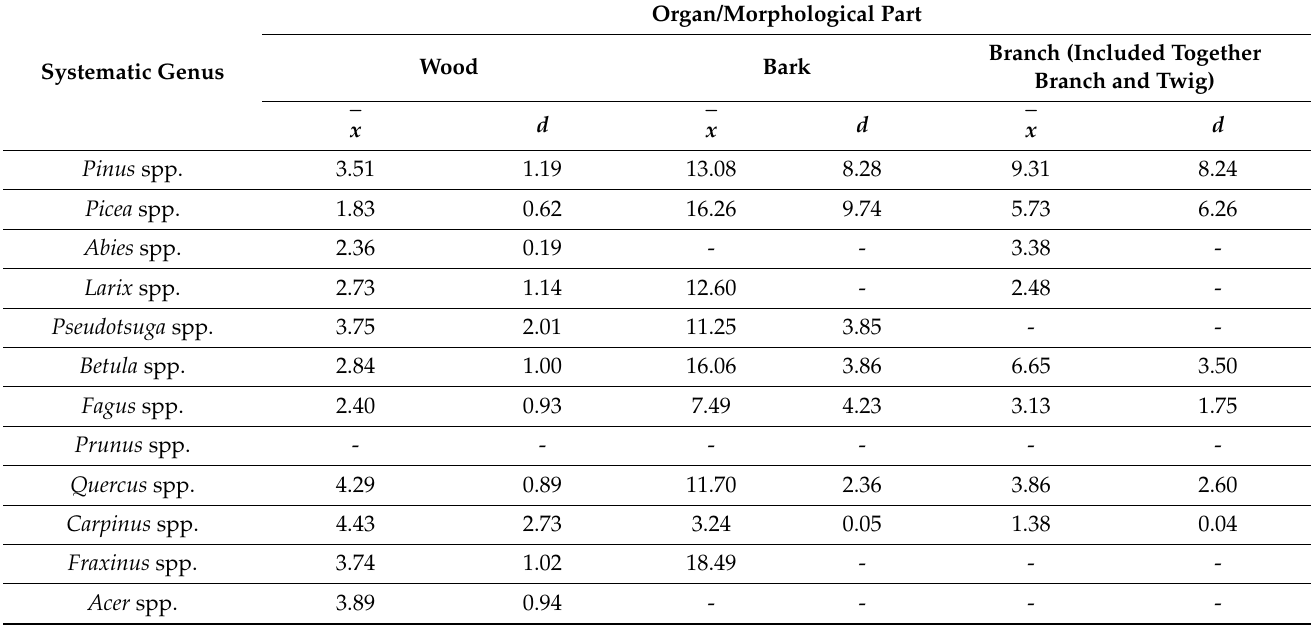
Table A24. Average value and average deviation of the other extracts content (% d.m.) in various organs of particular systematic genera